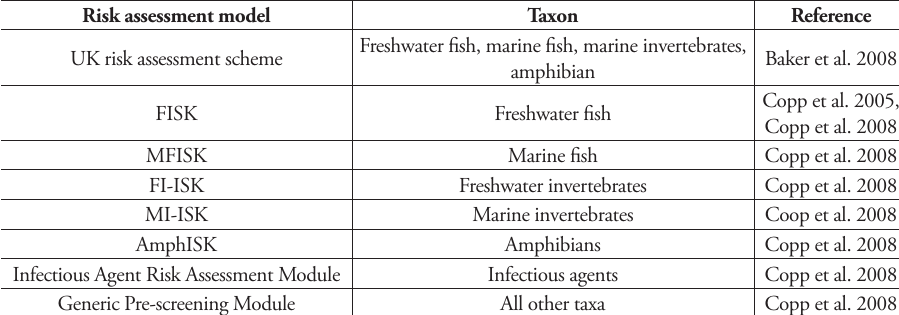
Table 1. Examples detailing when the AWRA has been adapted for use on taxa other than